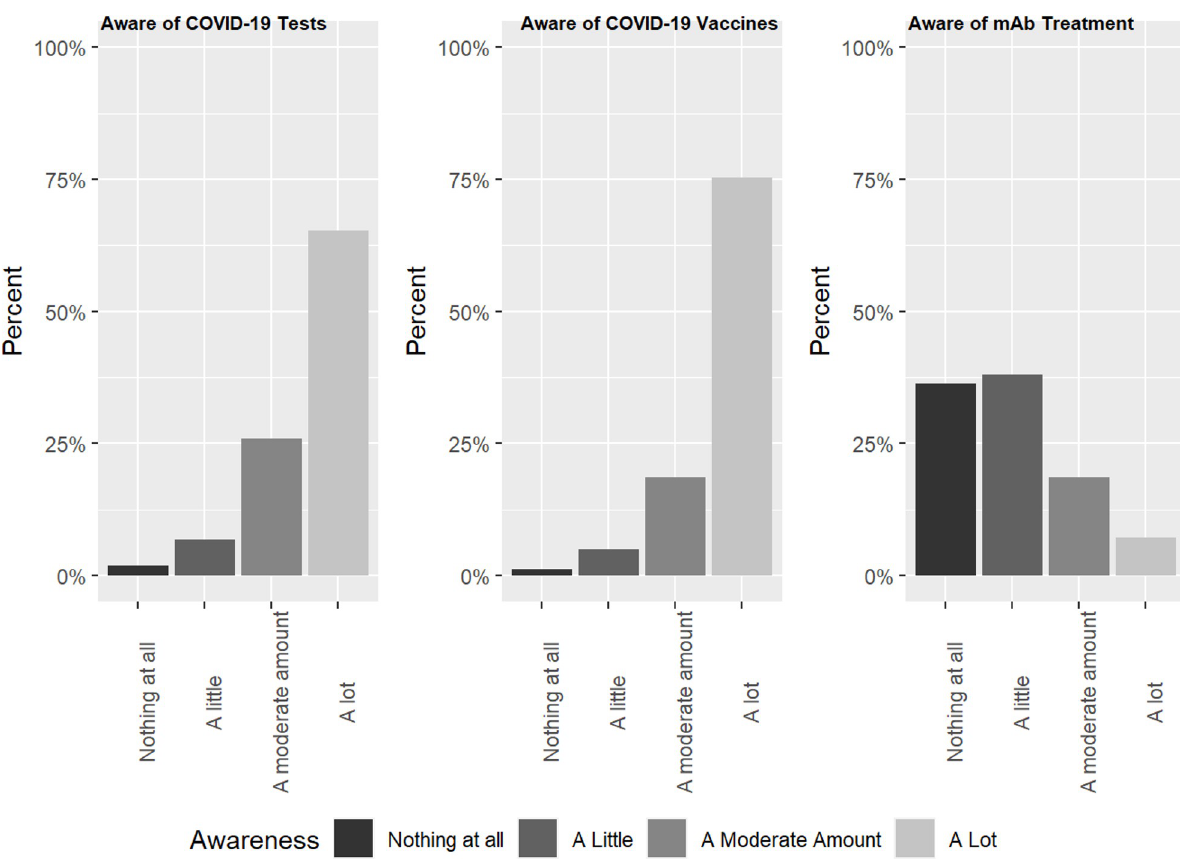
Fig 1. Awareness of COVID-19 tests, vaccines, and mAb treatment in Colorado.